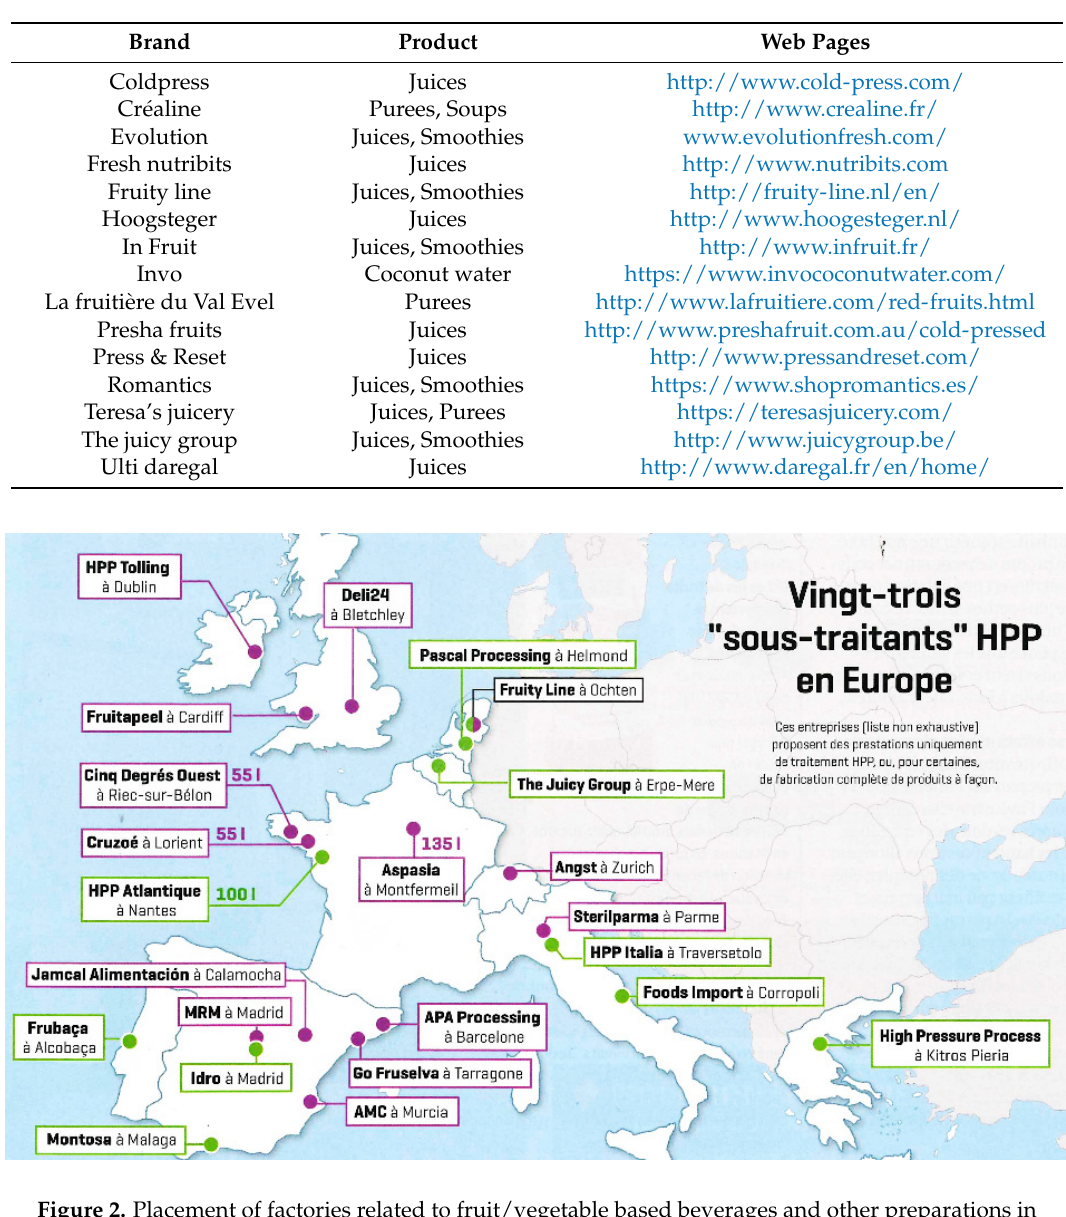
Table 1. Brands, webpages and fruit/vegetable products treated by HPP in the European Union (EU) market.